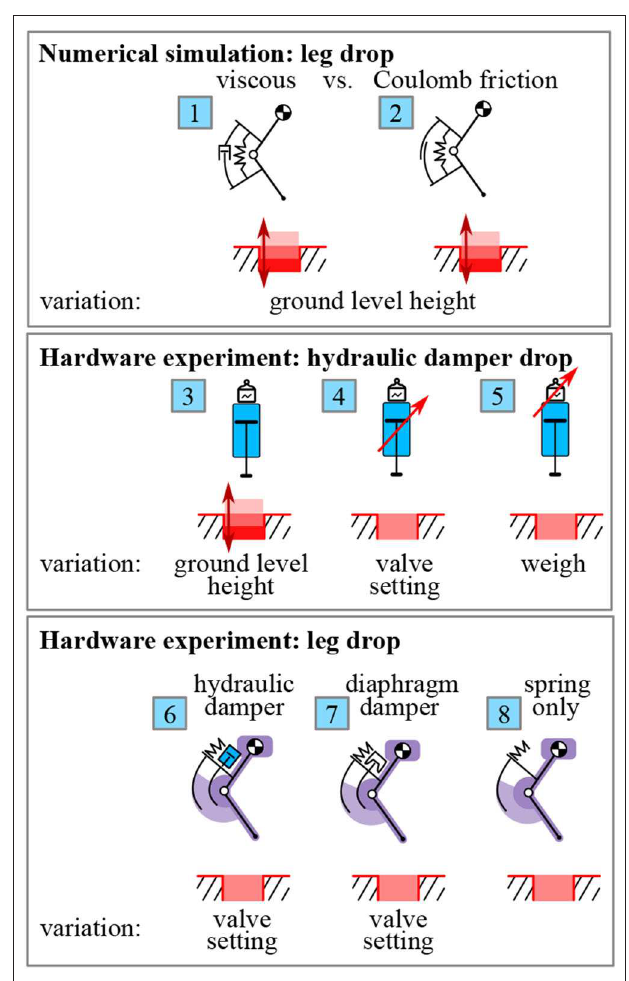
FIGURE 2 | Overview: We study the effective dissipated energy E effective in drop experiments, i.e., the energy dissipation within one drop cycle between touch-down and lift-off ( Figure 6 ). We focus on a system design with a damper and a spring, both acting in parallel on the knee joint ( Figures 1D , 3 ). No active motor is considered as it is not relevant for the drop scenario, but required for continuous hopping. In numerical simulations, we quantify the difference in energy dissipation between viscous 1 and Coulomb 2 damping for varying ground level heights (section 2 and Figure 4 ). The first set of hardware experiments characterizes the industrial hydraulic damper. For this, we drop the isolated damper (damper only, not mounted in the leg) on a force sensor and calculate the energy dissipation. We vary the ground level height 3 , the valve setting 4 and the drop mass 5 , to investigate its dynamic characteristics (section 4.1 and Figure 7 ). For the second set of hardware experiments, we drop a 2-segment leg with dampers mounted in parallel to knee springs. We investigate the energy dissipation dynamics of the hydraulic 6 and diaphragm damper 7 by comparing it to a spring-only condition 8 , where the damper cable is simply detached (section 4.2 and Figure 8 ). We also vary the valve setting on the dampers to test the dynamic adjustability of damping (section 4.3 and Figure 9